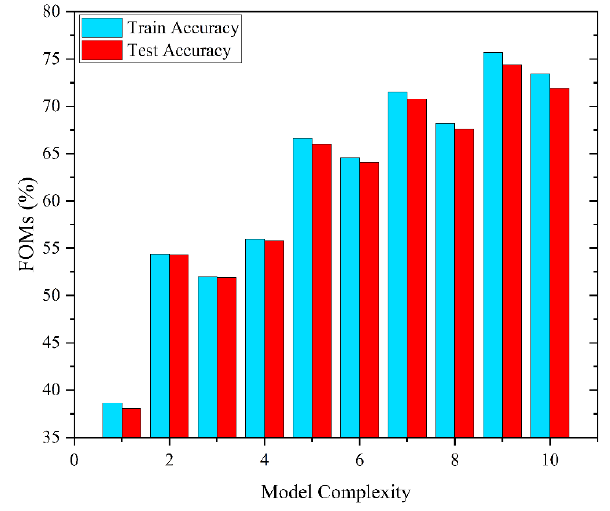
Figure 6. Effect of model complexity on train and test accuracy.